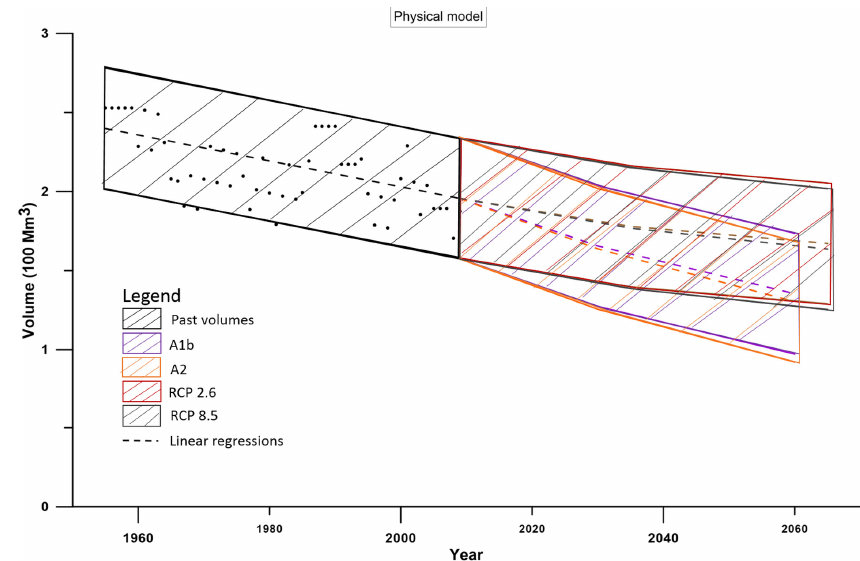
Figure 5. Graph, with the shaded areas representing the effective volume of Shela aquifer and projected volumes for all four climate change scenarios, as well as the uncertainties.